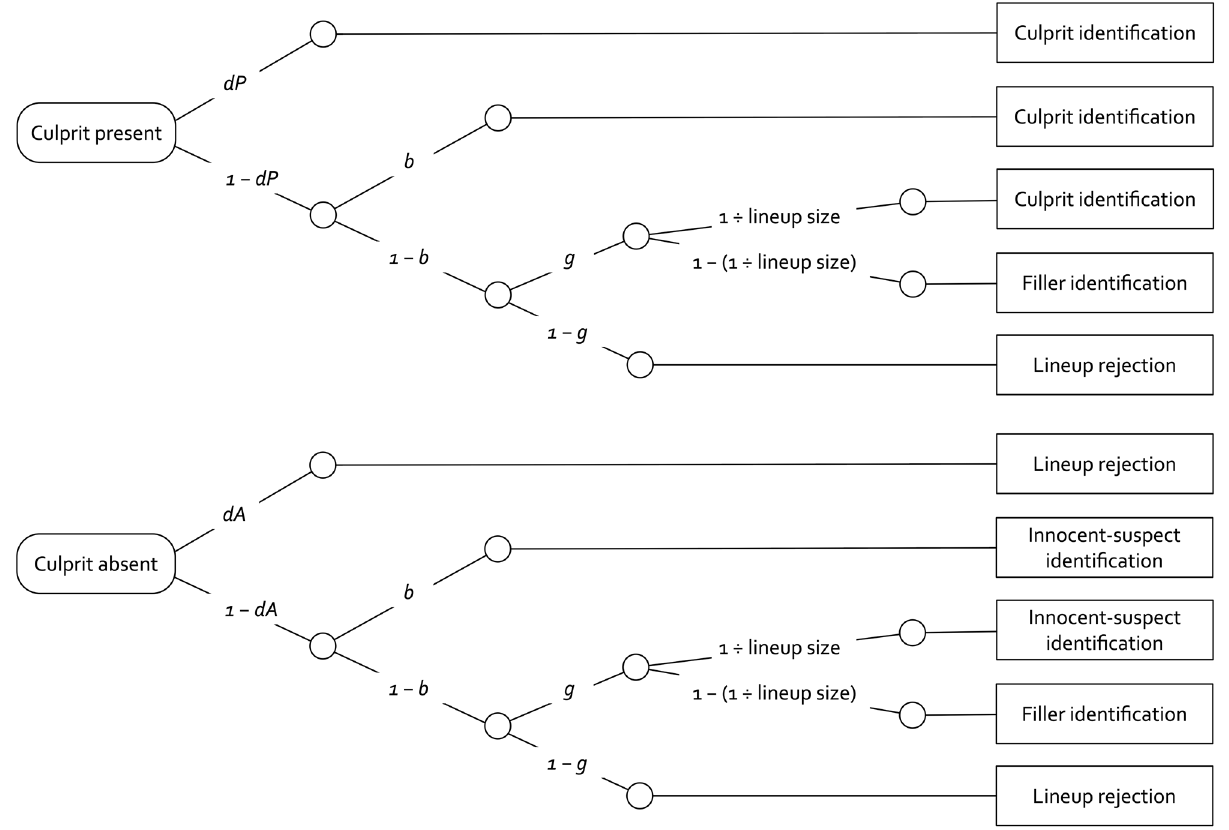
Figure 1. The 2-HT eyewitness identification model 32,34 . The rounded rectangles on the left represent the lineup types presented to the participants: culprit-present and culprit-absent lineups. The parameters attached to the branches of the trees denote transition probabilities of the latent cognitive processes postulated by the model ( dP: probability of detecting the presence of the culprit; b: probability of biased selection of the suspect; g: probability of guessing-based selection among the lineup members; dA: probability of detecting the absence of the culprit). Lineup size represents the number of persons in the lineup. The rectangles on the right side show the categories of the observable